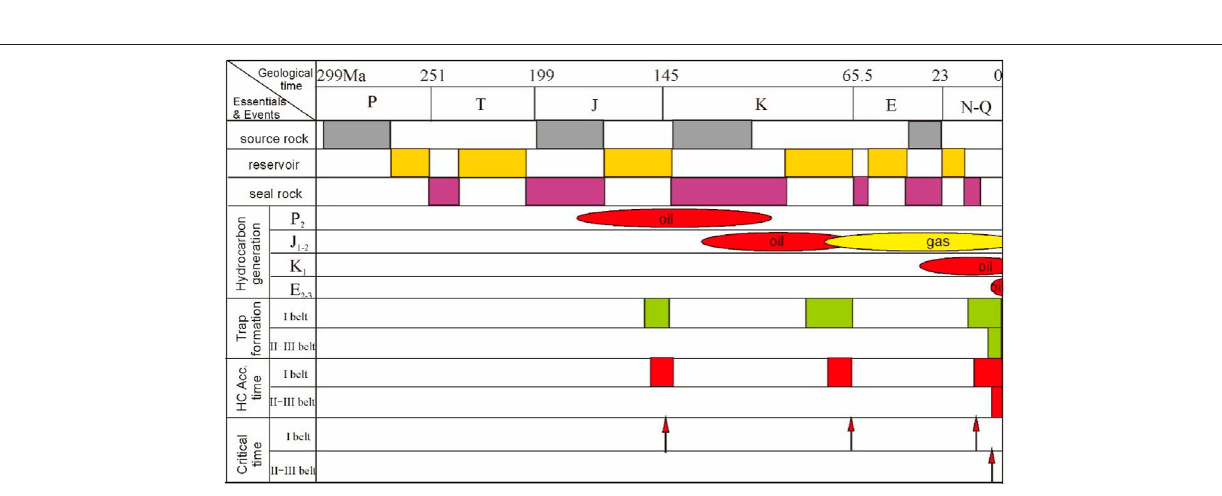
Frontiers in Earth Science |